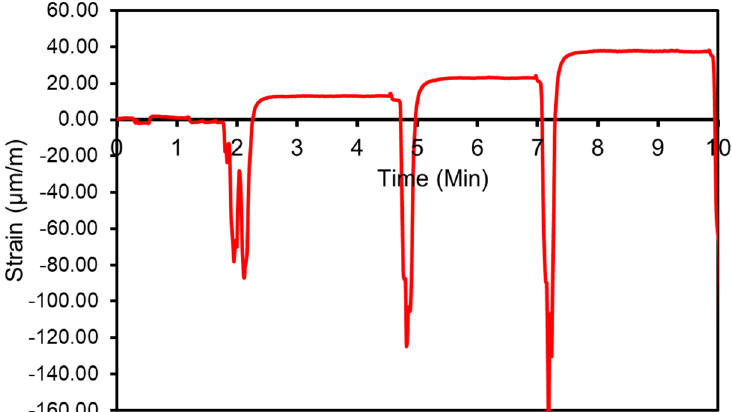
Figure 11. Strain measurement in GFRP focusing on the first three drilling increments. Data were recorded every 2 s.